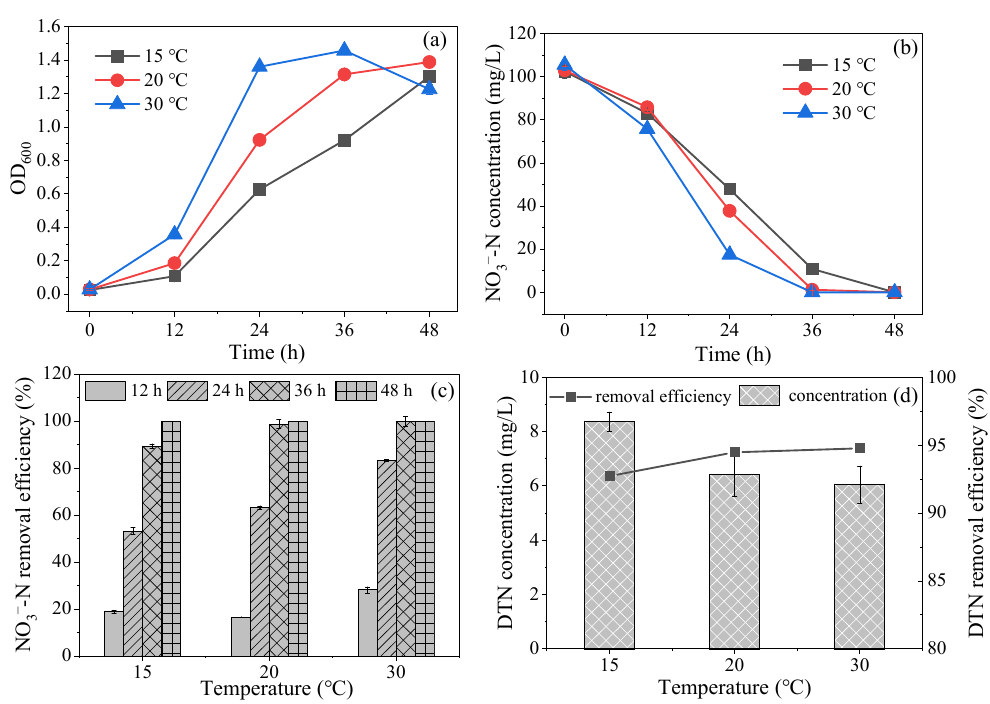
Figure 7. Effect of temperature on nitrogen removal performance of strain 41. ( a ) Growth curves of strain 41; ( b ) variation of NO 3 − -N concentration; ( c ) removal efficiency of NO 3 − -N; ( d ) characteristics of DTN removal.